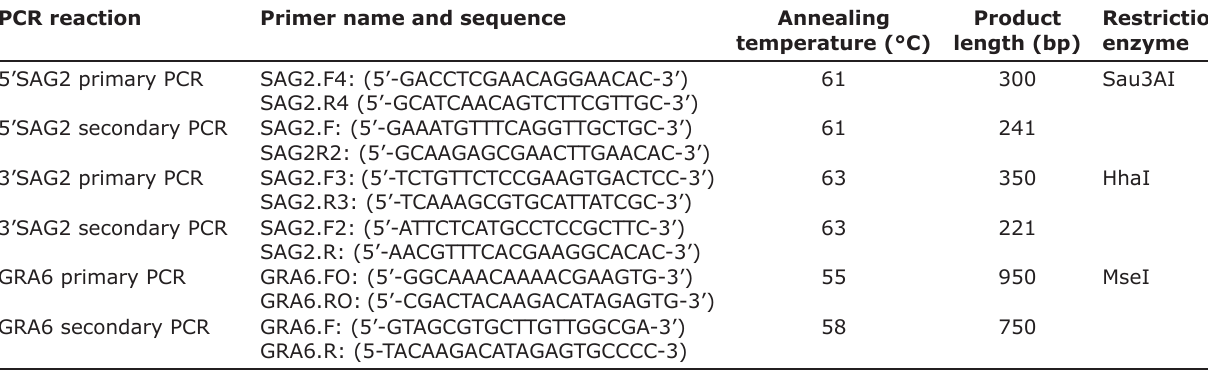
Table-1: Names and sequences of the PCR primer pairs